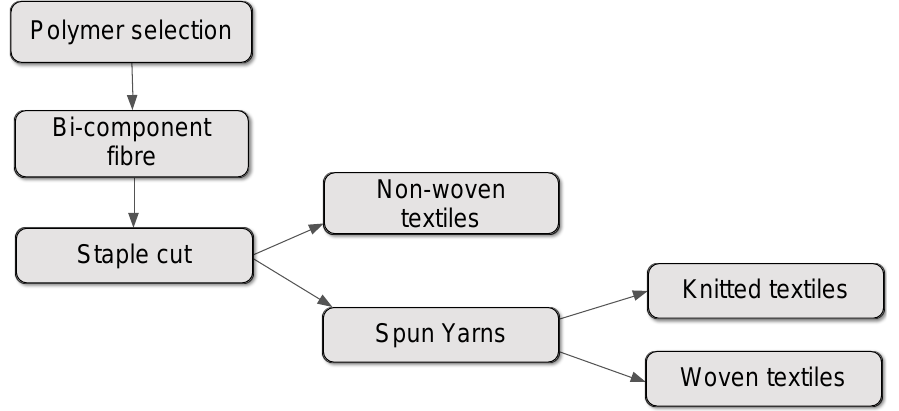
Figure 12. Process map describing research and development scope developed by MMT Textiles Ltd.